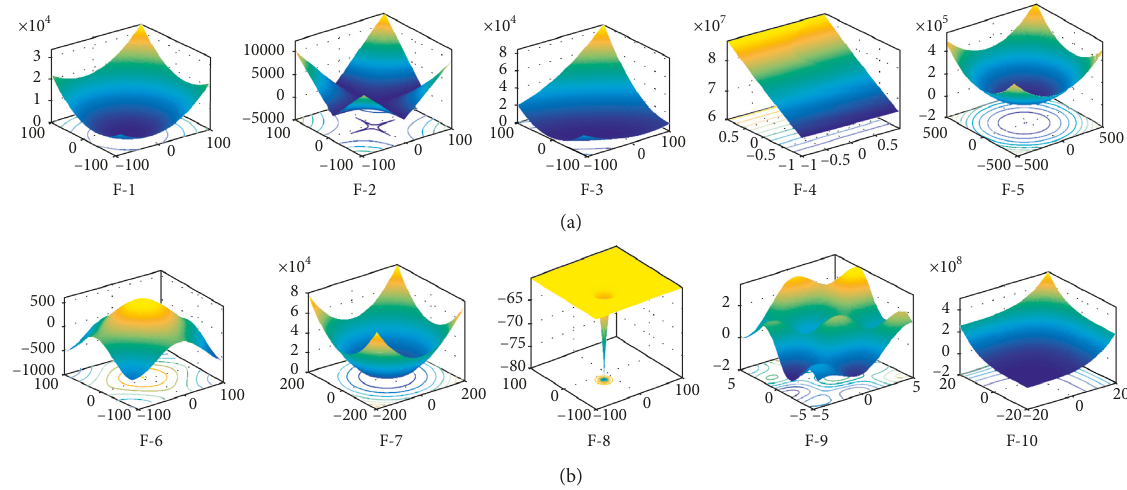
Figure 3: Shifted and biased benchmark functions. (a) Unimodal and (b) multimodal test functions. Table 2: Benchmark functions [28–31]. Function